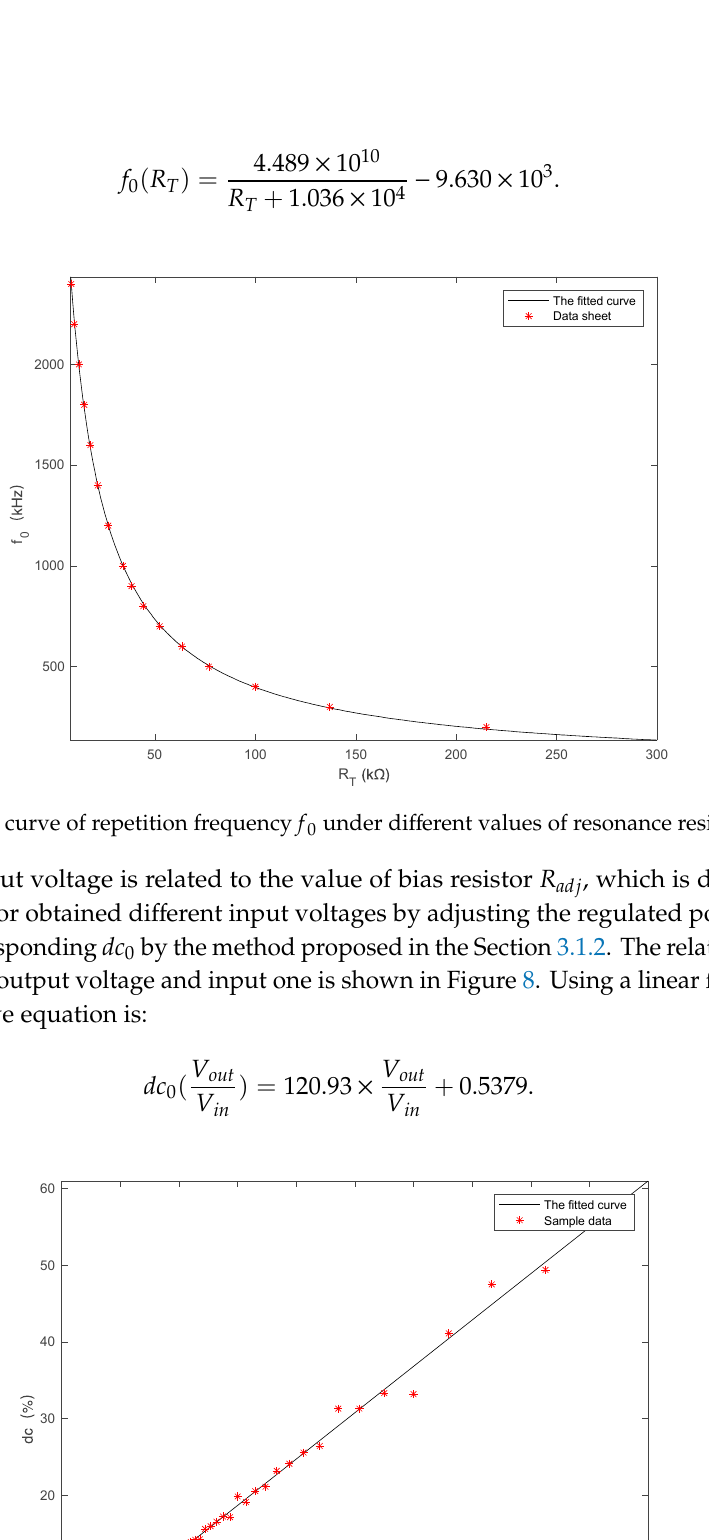
Figure 9. De-embedding principle [26]. The block diagram of the measurement setup of proposed method in this paper is shown in Figure 10. The coupling relationship can be expressed as Equation (10).